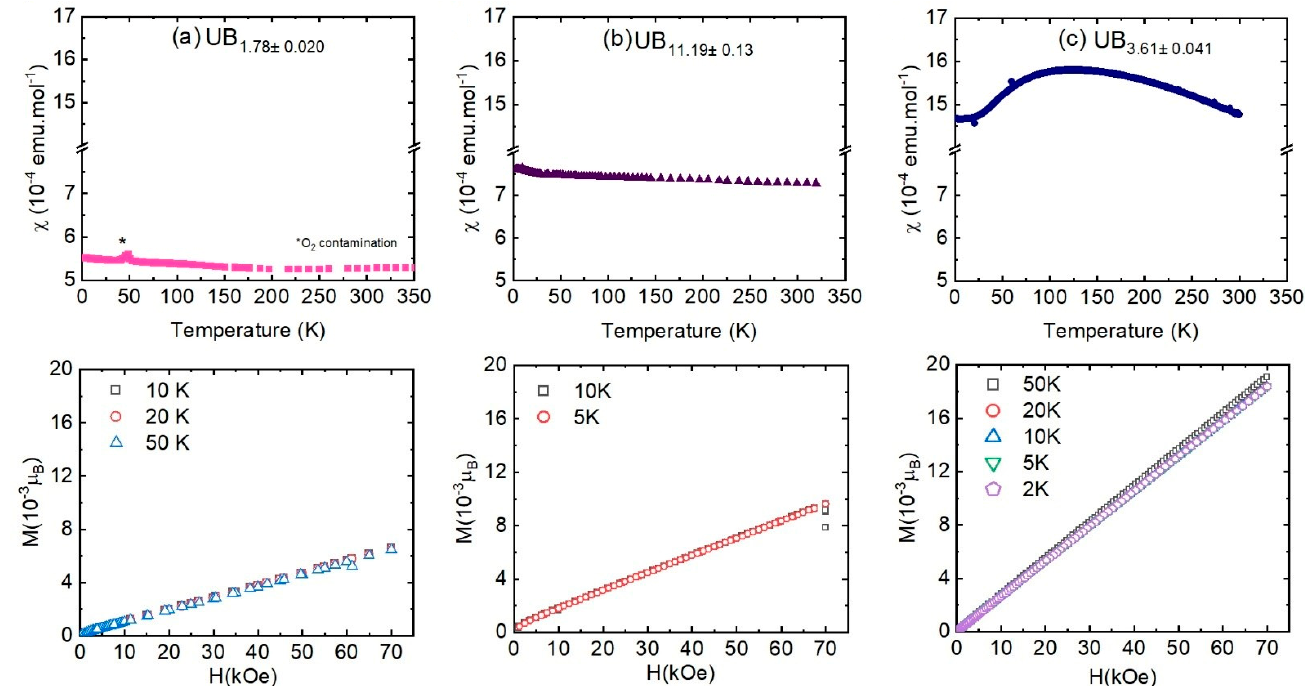
Figure 3. Magnetic susceptibility curves against temperature (top) and magnetization against field (bottom) for ( a ) UB 1.78 , ( b ) UB 11.19 , and ( c ) UB 3.61 .